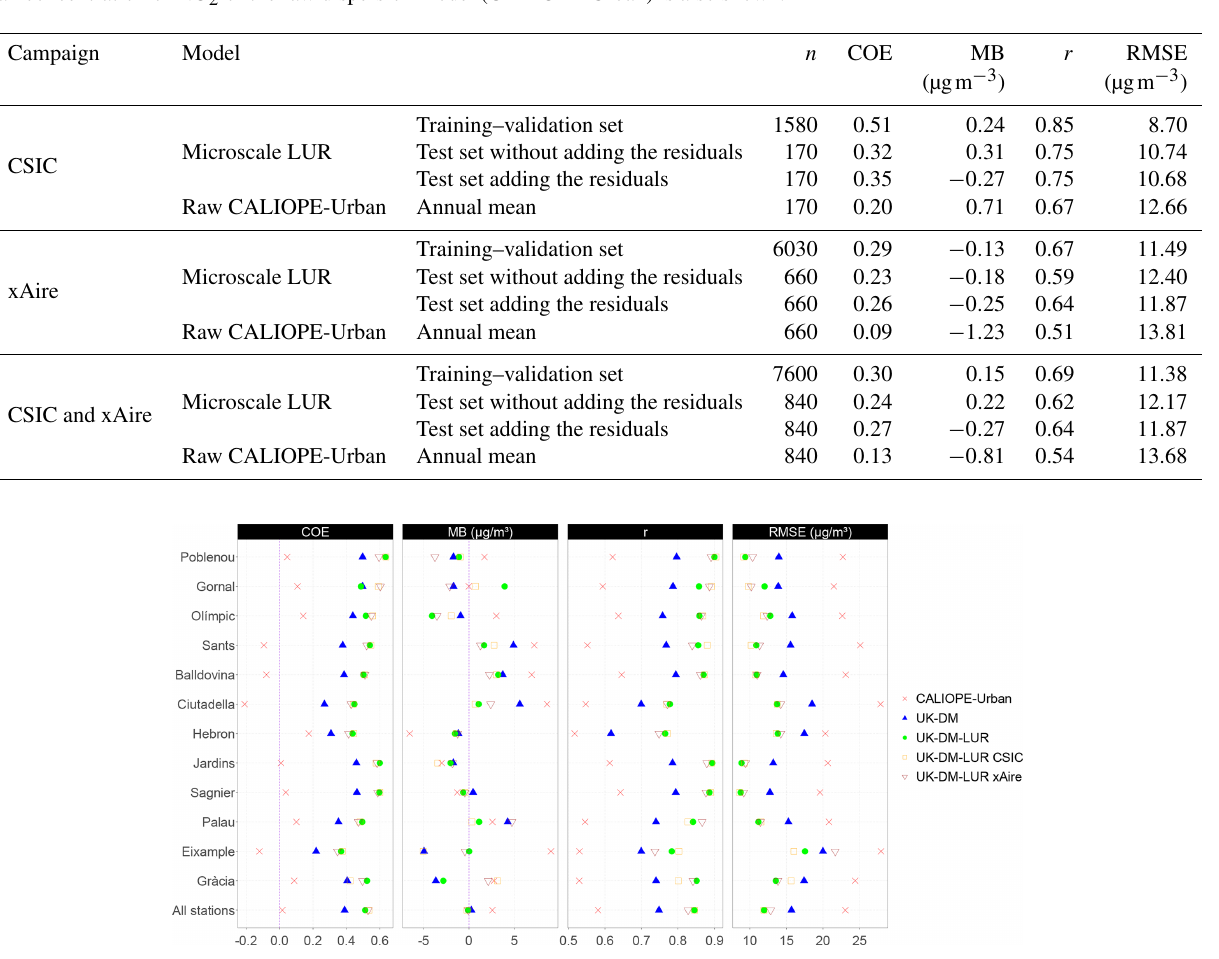
Table A1. Statistical results of the microscale LUR model in nested CV, considering both campaigns or only one of them. The 2017 annual mean concentration of NO 2 of the raw dispersion model (CALIOPE-Urban) is also shown.